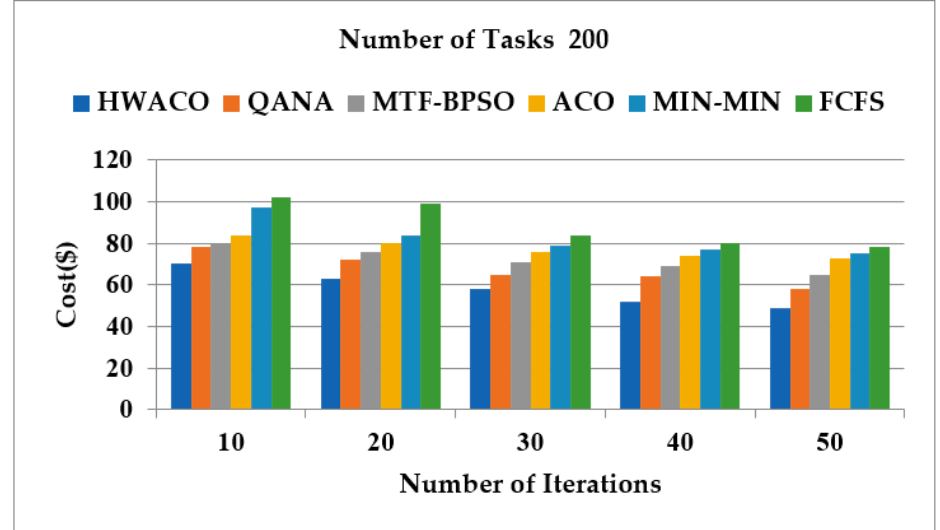
Figure 6. The task cost values of 200.